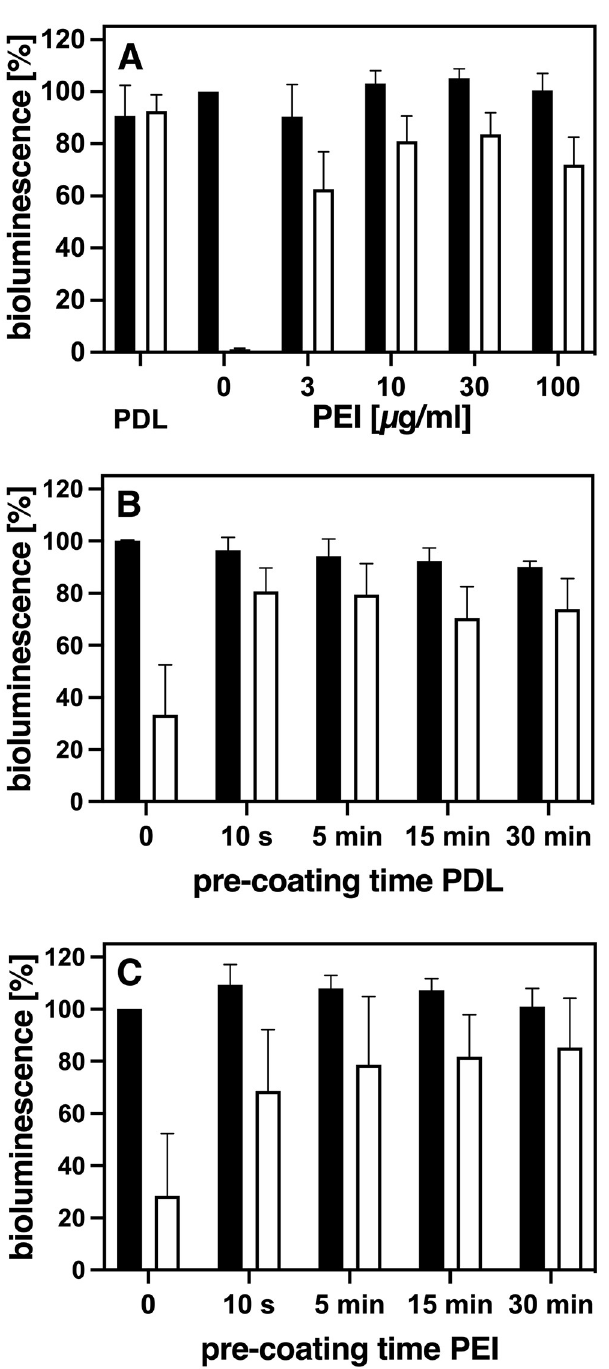
Fig 2. Pre-coating with increasing PEI concentrations, or with prolonged pre-coating times with either PDL or PEI. A) Wells were pre-coated either with 100 μ l of PDL (100 μ g/ml) or increasing concentrations of PEI (3–100 μ g/ml) for at least 1 h. B) and C) Wells were pre-coated for only 10 s or for up to 30 min with either (B) 100 μ g/ml PDL or (C) 10 μ g/ml PEI. The pre-coating solutions were aspirated and HEK 293 cells expressing either GRPR55- or B 2 R R128A-RlucII constructs seeded immediately. Strength of cell attachment was estimated after 2–3 d by rinsing the cells with ice-cold PBS using a microplate-washer (white bars) as described in “Materials and methods”. For controls (black bars), cell culture medium was removed with a 12-channel pipette without any rinsing of the cells. Bioluminescence was determined as described in “Materials and methods”. Columns depict Mean ± SEM (n = 3–6, performed in duplicates). The wells without pre-coating and without rinsing were taken as